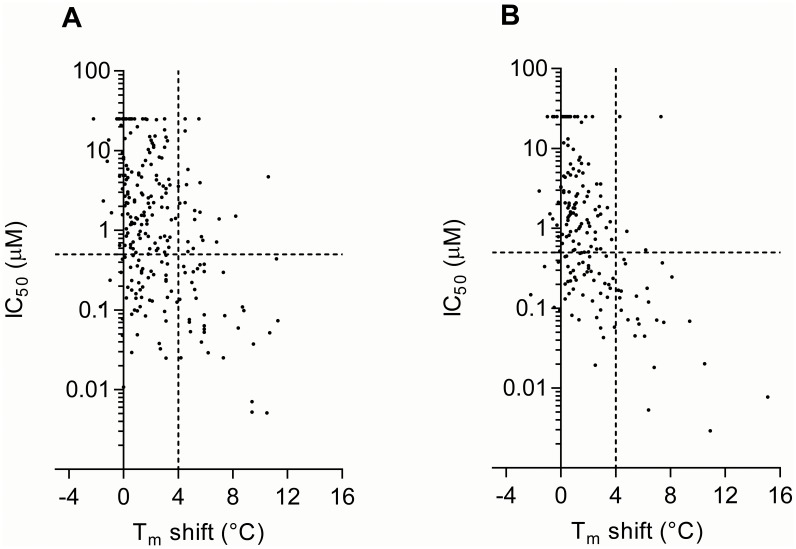
Binding and activity-based screening data comparison based on kinase-inhibitor pairs.Scatter plot comparison of our IC50 and Tm shift data divided into proteins with only the catalytic domains (A) and proteins with additional domains/subunits only (B). The dashed horizontal line corresponds to an IC50 of 0.5 µM. The dashed vertical line in the plots of 4°C Tm shift corresponds to a binding affinity <1 µM. A significant correlation of binding and inhibition is observed (P<0.001).